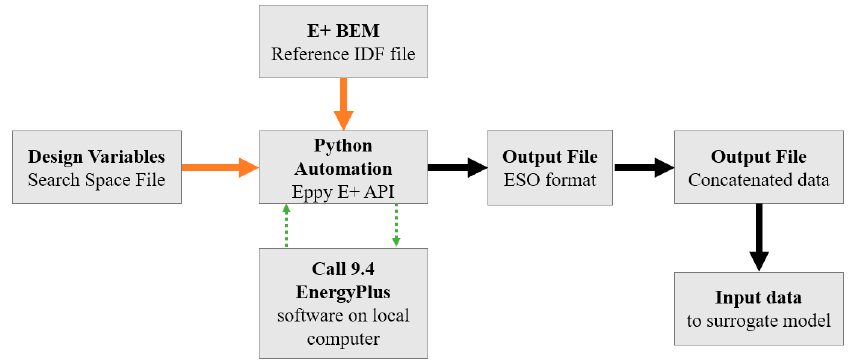
Figure 5. Steps toward building a surrogate model.